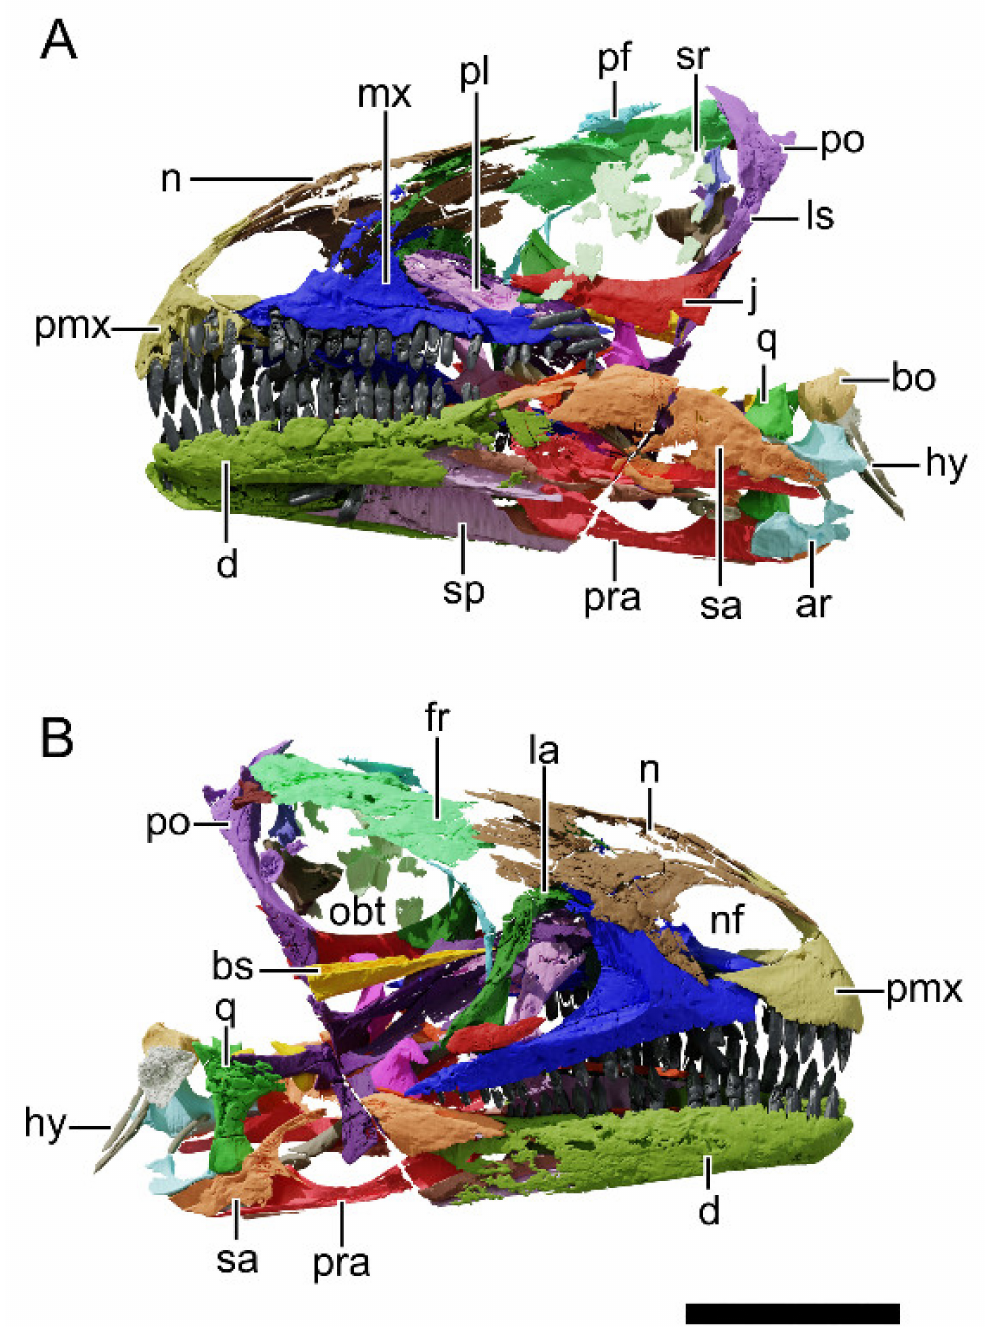
Figure 6. Digital reconstruction of the skull of NHMD 164758. ( A ) Left lateral view. ( B ) Right lateral view. Abbreviations: ar, articular; bo, basioccipital; bs, basisphenoid; d, dentary; fr, frontal; hy, hyoid; j, jugal; la, lacrimal; ls, laterosphenoid; mx, maxilla; n, nasal; nf, narial fenestra; obt, orbit; pf, prefrontal; pl, palatine; pmx, premaxilla; po, postorbital; pra, prearticular; pt, pterygoid; q, quadrate; sa, surangular; sp, splenial; sr, sclerotic ring. Scale bar = 50